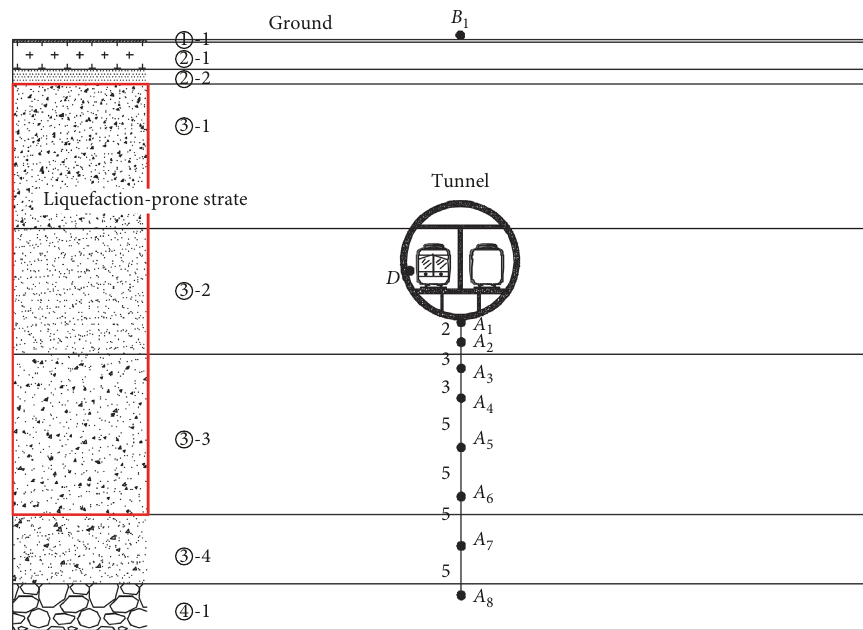
Figure 9: Profile of the soil types beneath the